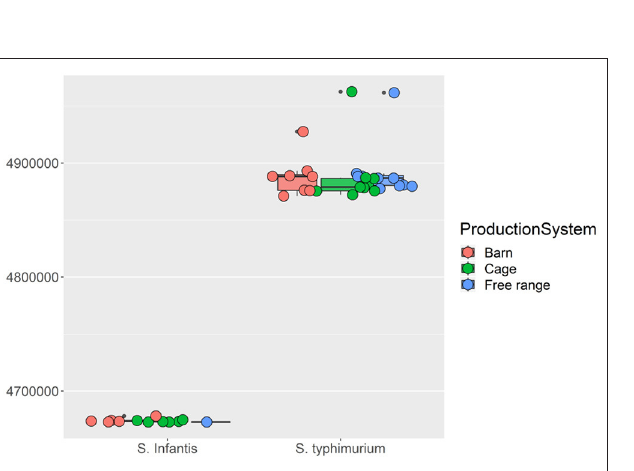
FIGURE 2 | The functional annotation of the genes identified from collected isolates.